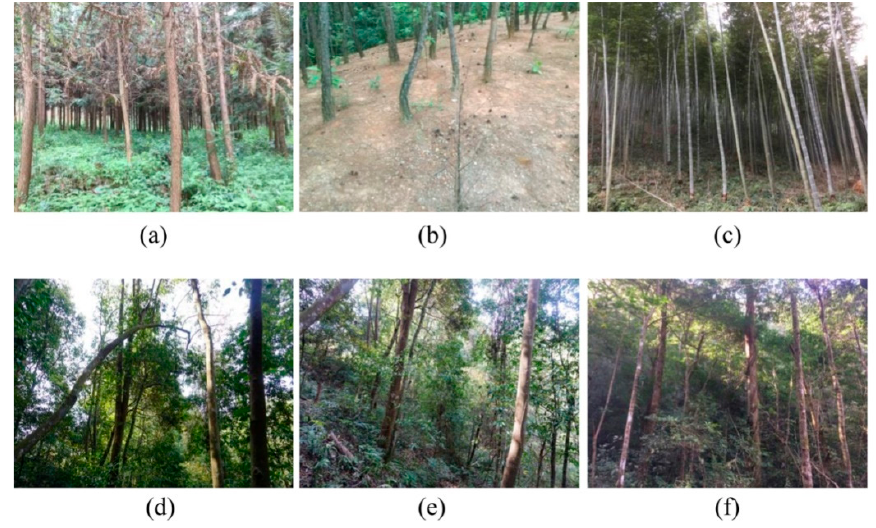
Figure 2. Vegetation characteristics in the study area; ( a – c ) plantation; ( d – f ) natural forests.